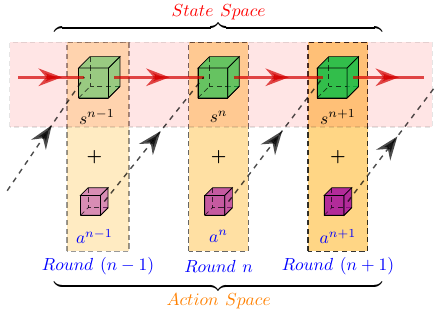
Figure 7. The coupling relationship between microgrid operators’ actions and market supply demand